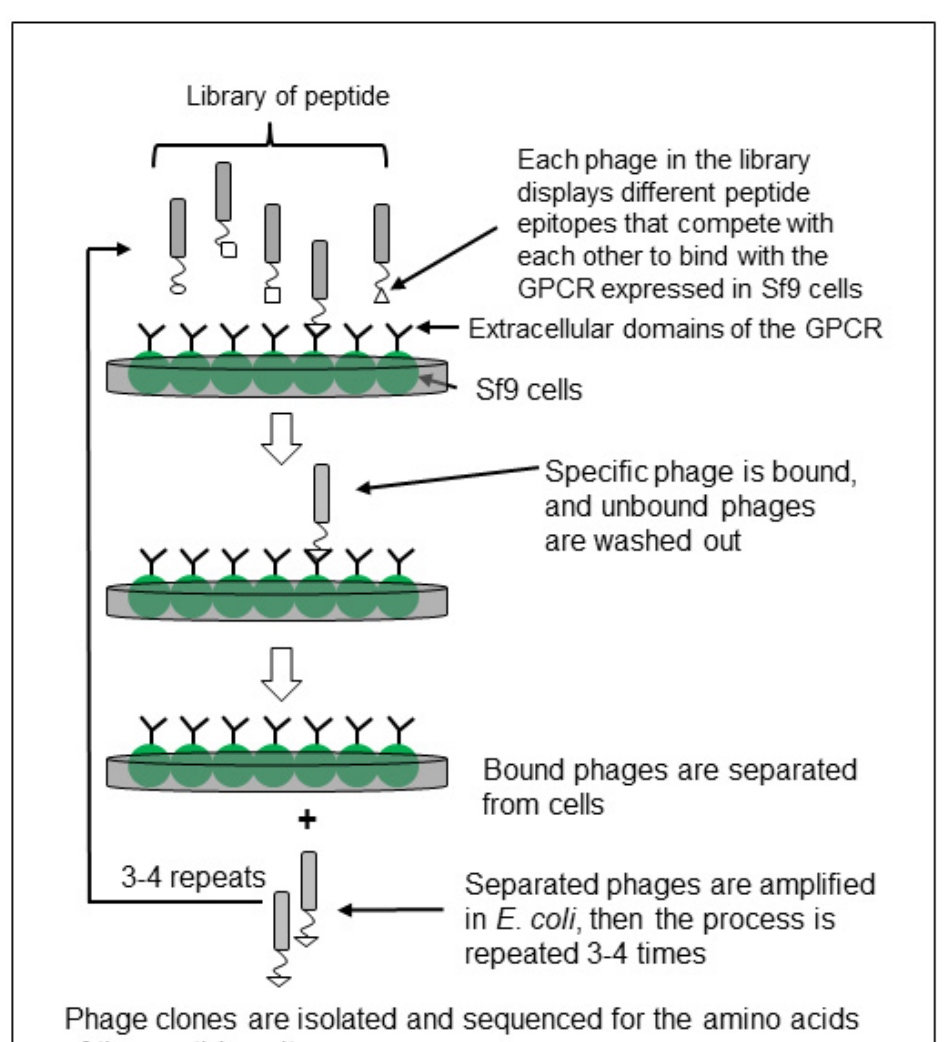
Figure 1. A schematic diagram of GPCR (G-Protein-Coupled Receptor) based screening using a phage display peptide library and biopanning using the insect Sf9 cell expression system. This process requires less than two weeks to obtain amino acid sequences of small peptide molecules after the establishment of functional GPCR expression in the Sf9 insect cell line (see detail in Materials and Methods).